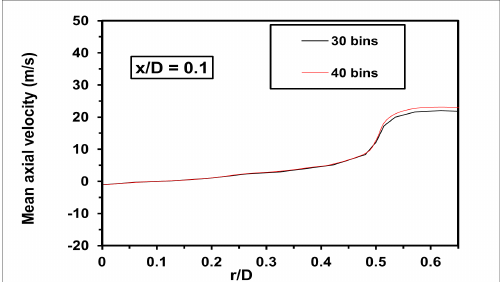
Figure 5. Sensitivity to the number of reactors: The computed mean velocity is compared to the ex- perimental measurements at axial locations x / D = 0.1.